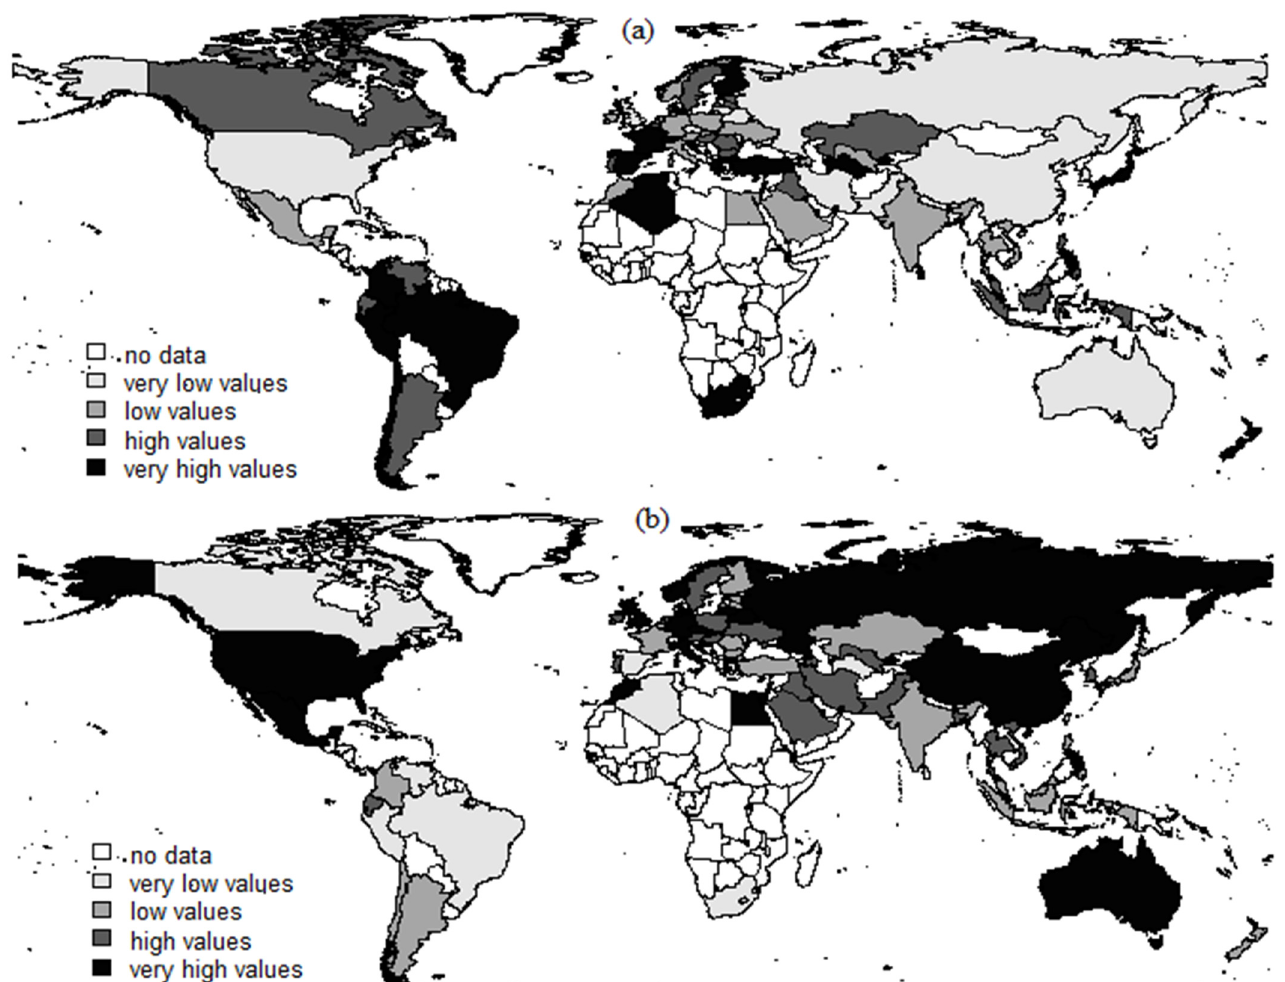
Figure 5. The distribution of the average impacts of ( a ) the spatially lagged renewable energy consumption on the CO 2 emissions in individual economies and ( b ) a change of the share of energy from renewable sources out of the total energy consumption in a particular economy on the CO 2 emissions in all other economies.